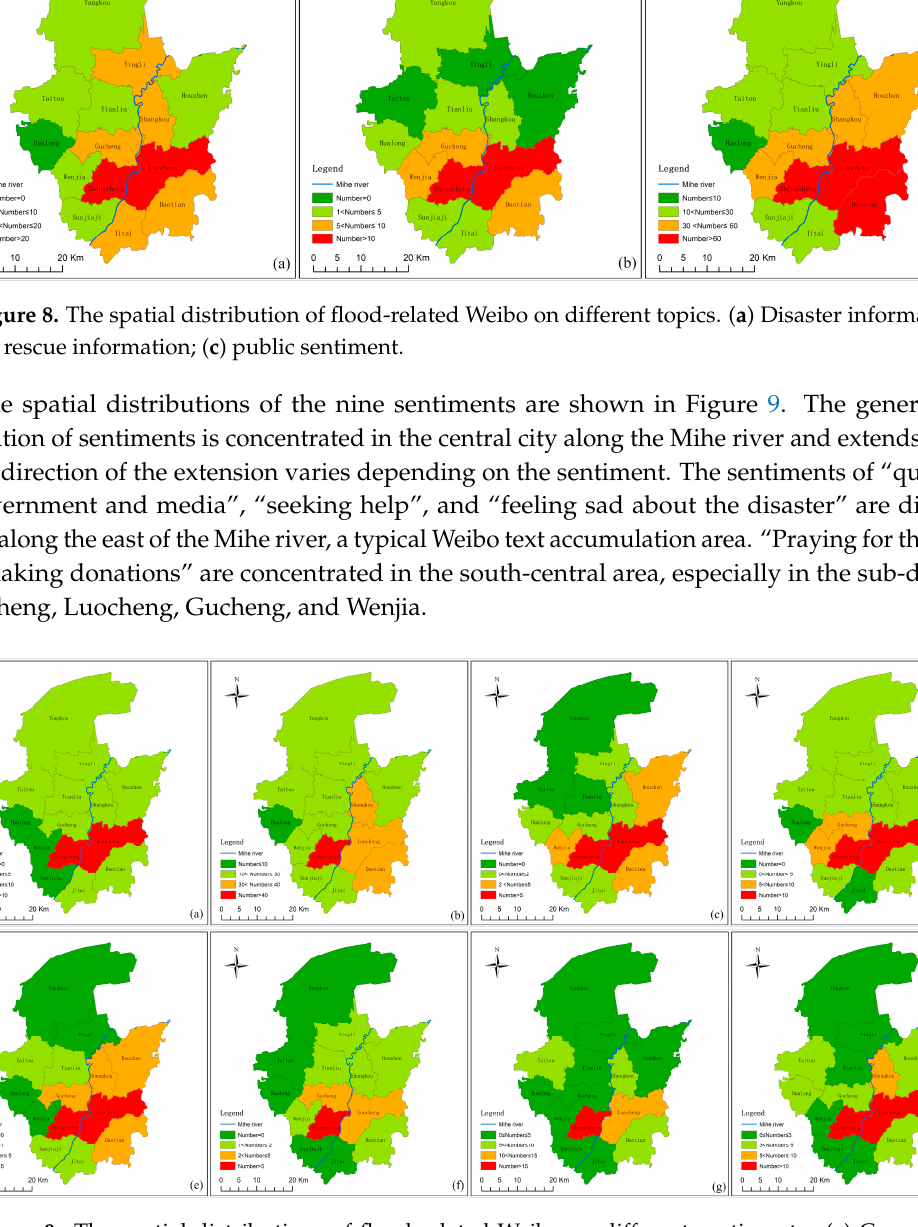
Figure 9. The spatial distributions of flood-related Weibo on different sentiments. ( a ) Concerned about the disaster situation; ( b ) questioning the government and media; ( c ) seeking help; ( d ) praying for the victims; ( e ) feeling sad about the disaster; ( f ) making donations; ( g ) thankful for the rescue; ( h ) worrying about vegetable prices.